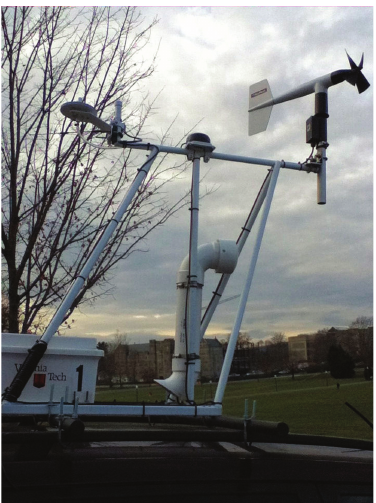
Figure 6: One of Virginia Tech’s Campbell Scientific mobile meteo- rological unit (photo, third author, 2013).